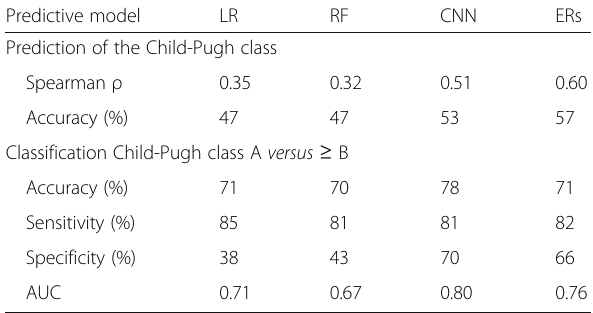
Table 4. Accuracy scores for all predictive